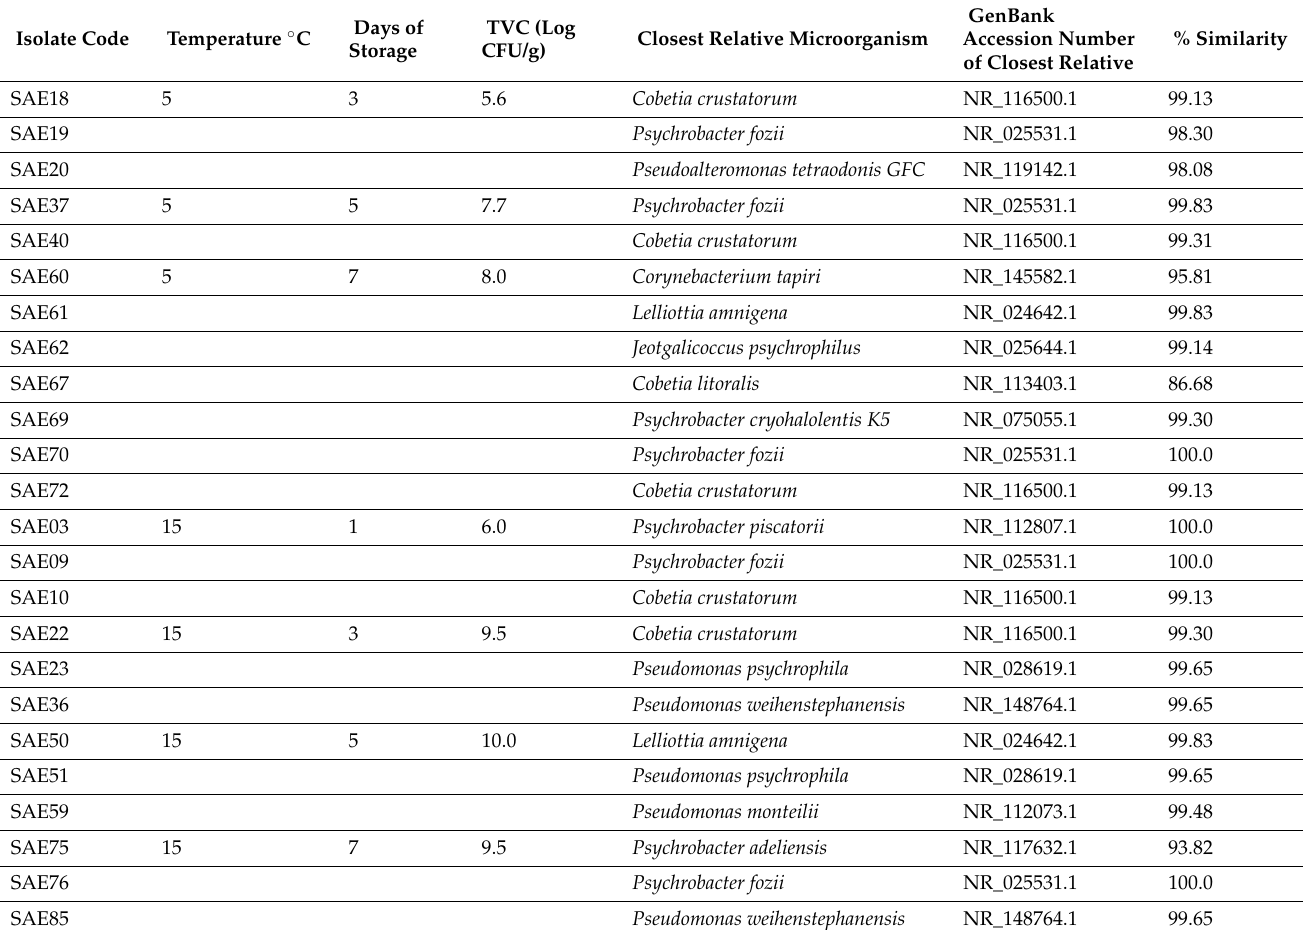
Table 3. Species identification of bacteria isolated from A. esculenta